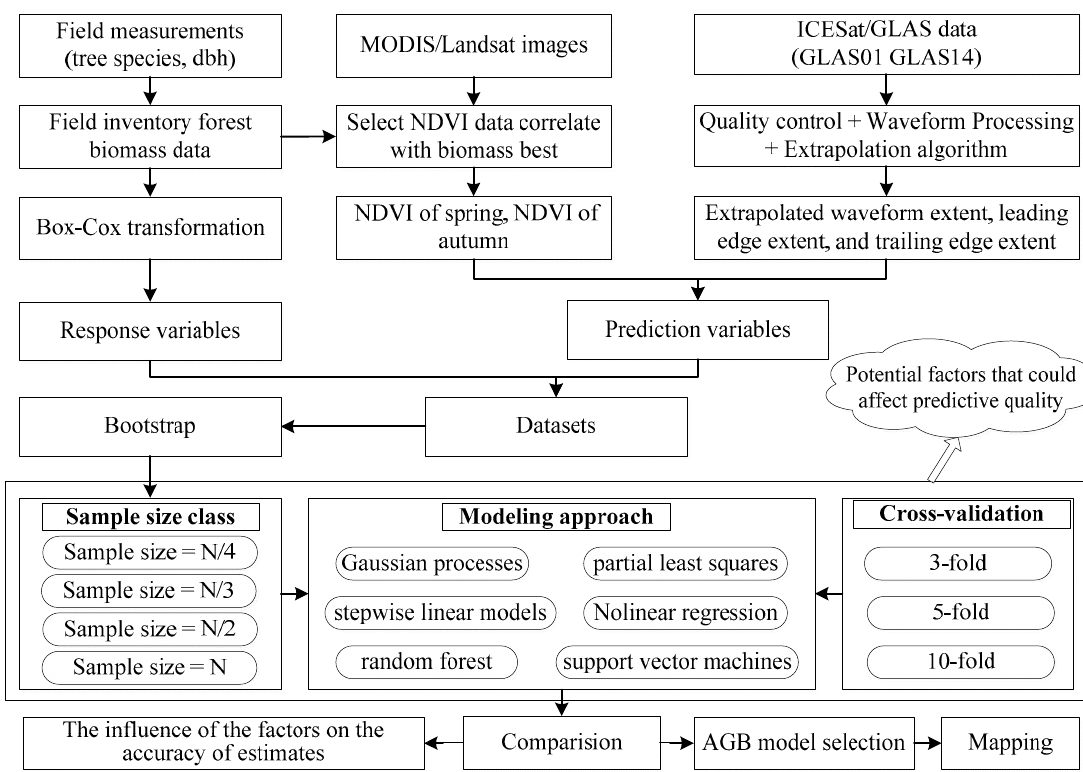
Figure 2. Schematic representation of the main methods followed in this study. Moderate Resolution Imaging Spectroradiometer (MODIS); Normalized Difference Vegetation Index (NDVI); diameter at breast height (dbh); Ice, Cloud, and land Elevation Satellite (ICESat), Geoscience Laser Altimeter System (GLAS), aboveground biomass (AGB).